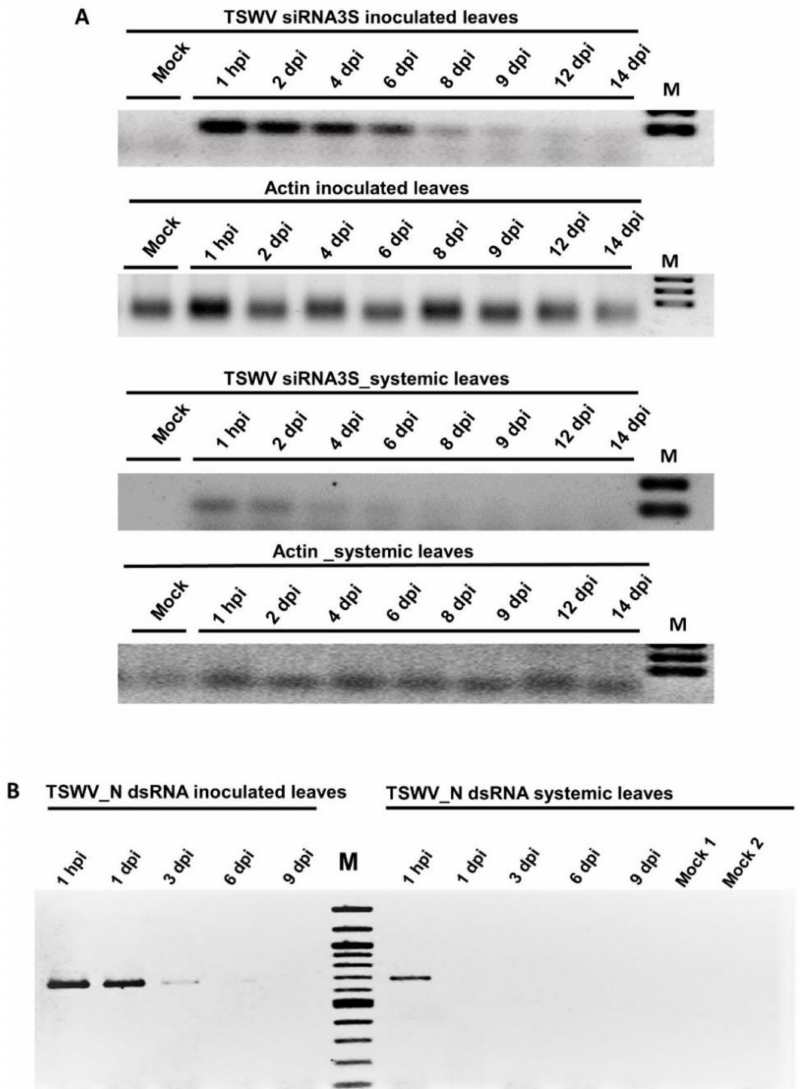
Figure 4. Movement of tomato spotted wilt virus (TSWV) dsRNA_N and siRNA3S in tobacco ( A ) Accumulation of siRNA3S from 1 hpi to 14 dpi. M: 100 bpt DNA ladder. ( B ) Detection of the TSWV_N dsRNA in inoculated and non-inoculated leaves at different time points. Mock 1 is mock-inoculated leaves, Mock 2 is younger, non-inoculated leaves from the same Mock 1